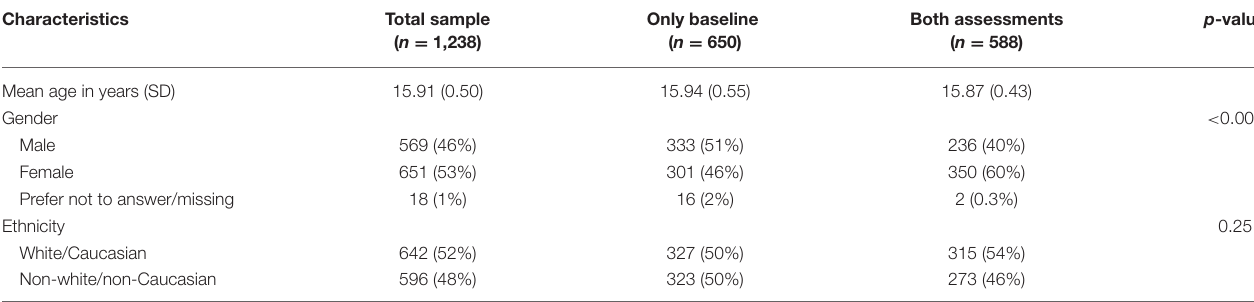
TABLE 1 | Baseline demographic